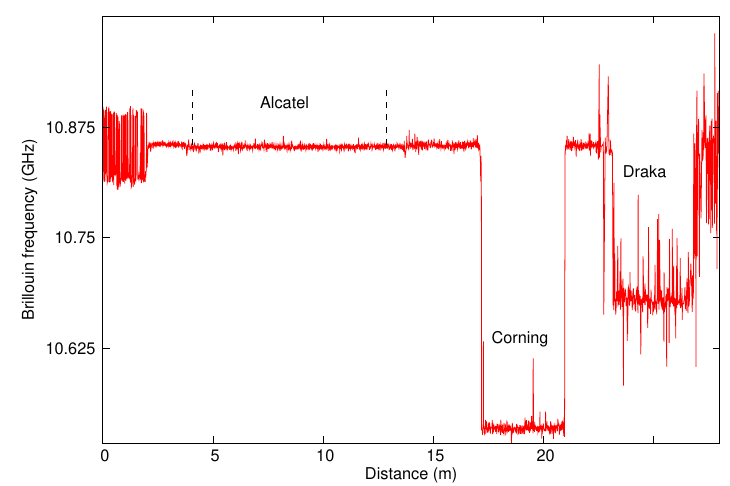
Figure 5. Measured Brillouin frequency along the bare fibres for a 20 ◦ C